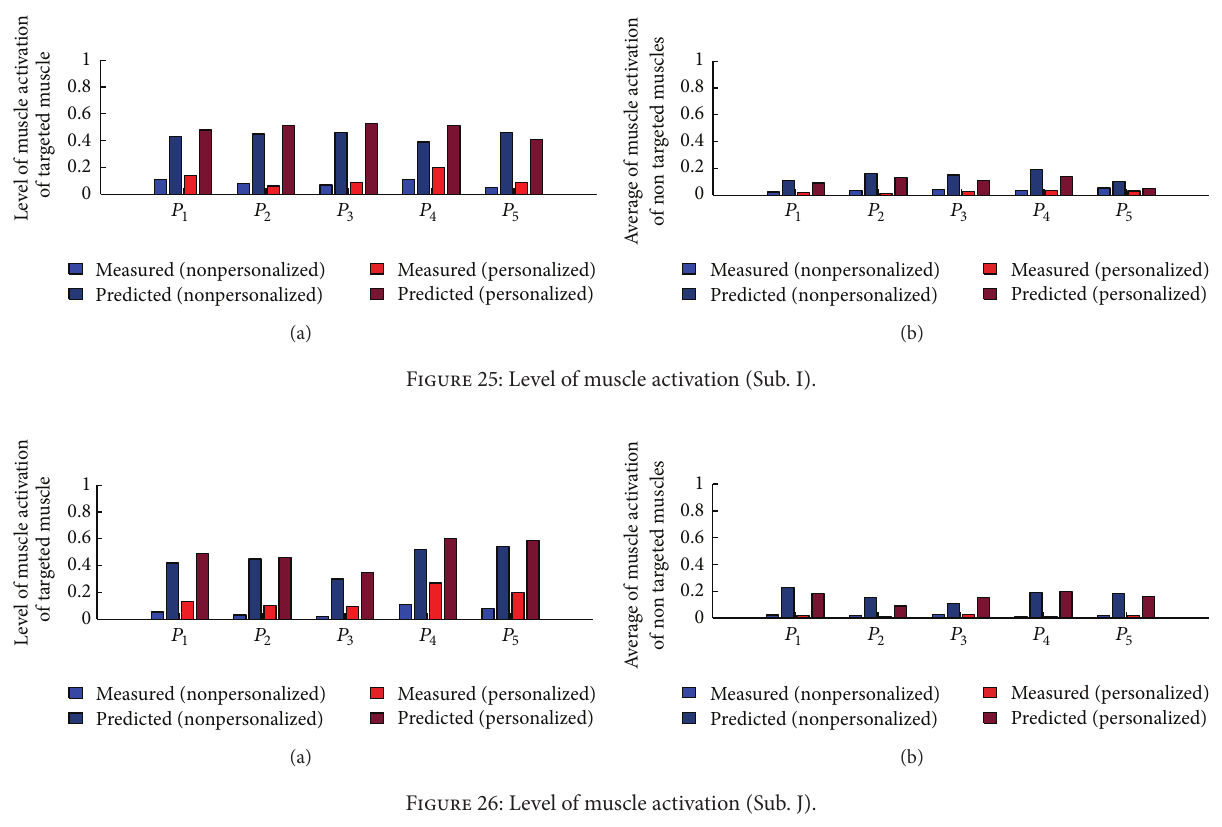
Figure 26: Level of muscle activation (Sub. J).